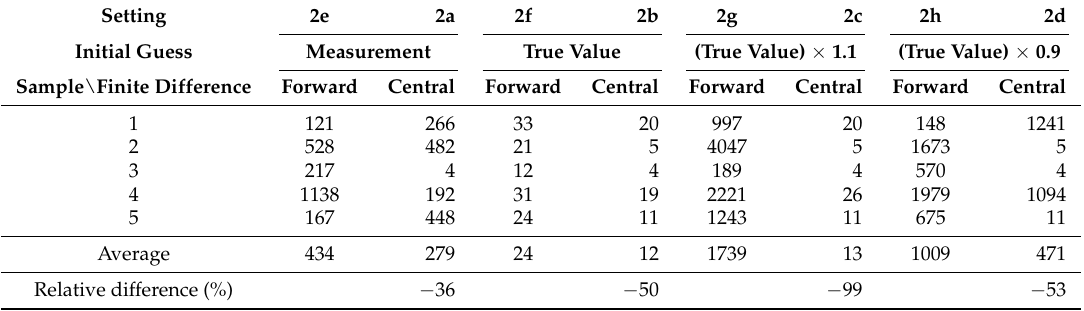
Table 7. Final objective function values after solving the DR problem as a function of the initial guess and type of finite difference.